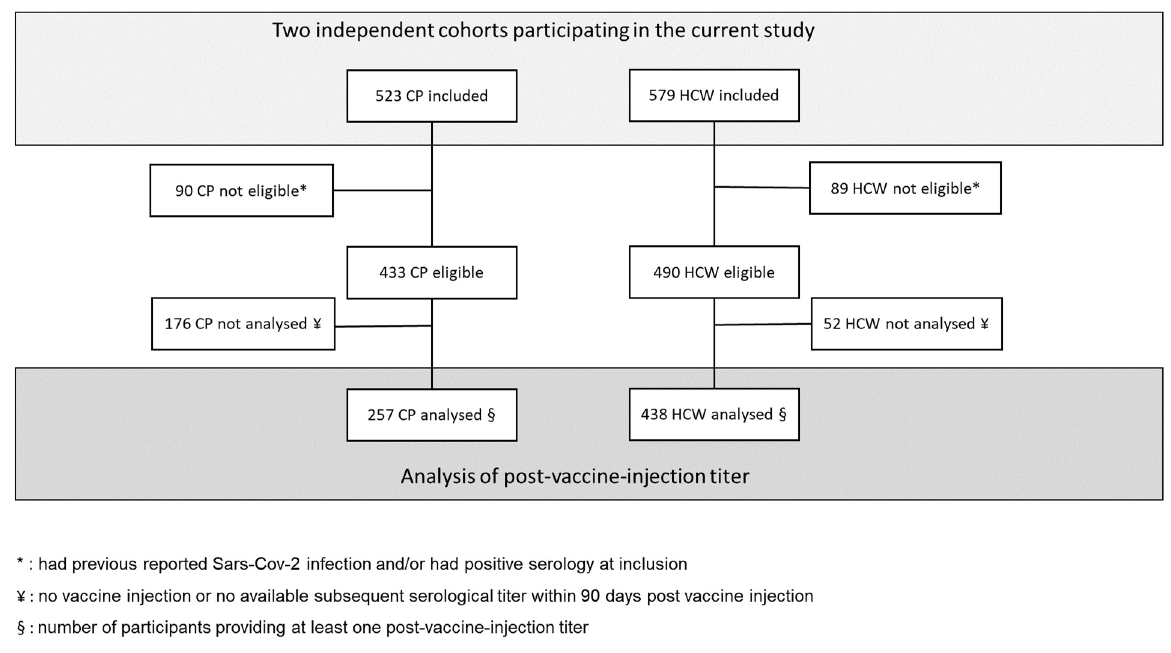
Figure 1. Flow-diagram for participant selection in both cohorts.